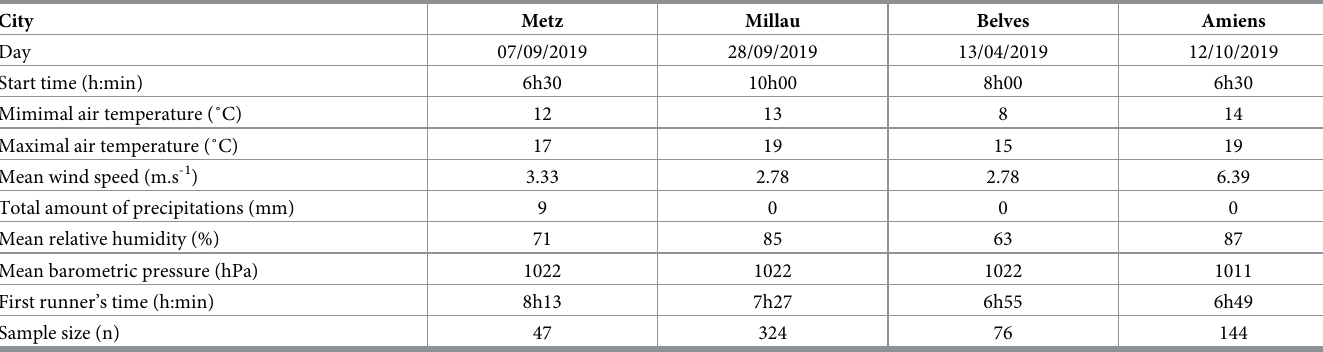
Table 3. Characteristics and environmental conditions during the 100-km